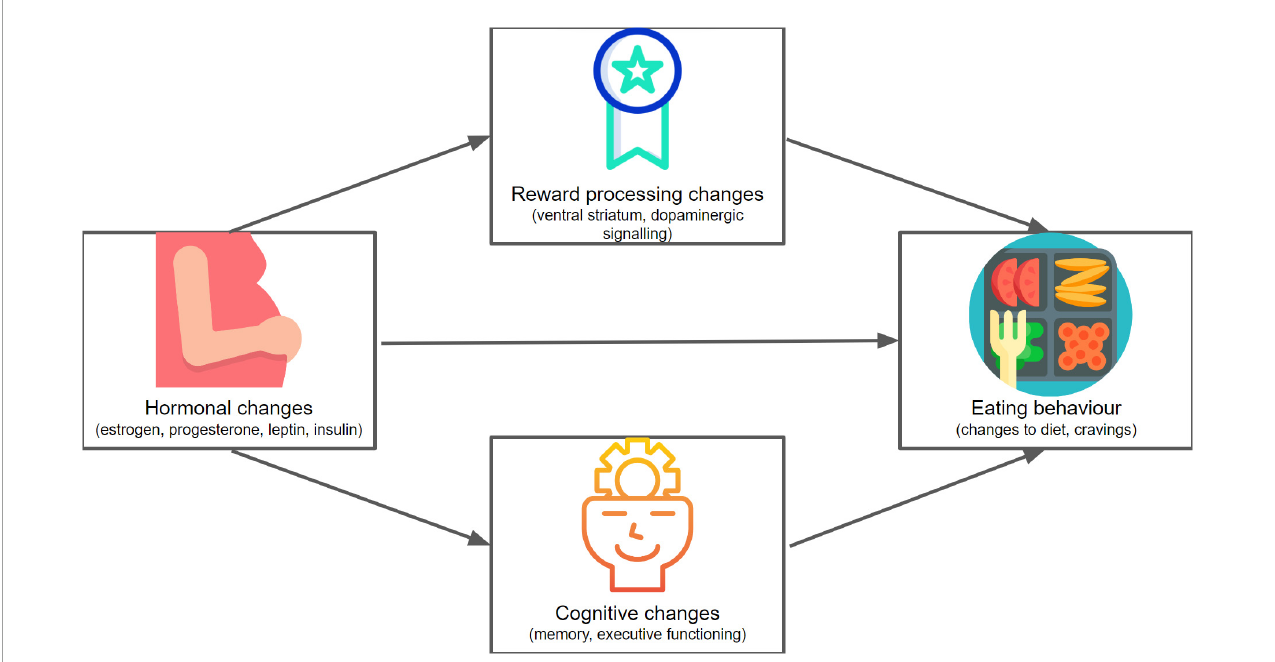
FIGURE1 A conceptual mapping of the framework of this review. We explore hormonal (including metabolic), reward-related, and cognitive changes in pregnancy, and consider how these might affect eating behavior. Icons made by Freepik (136, 137), Icongeek26 (138) and catkuro (135) from www.flaticon.com.